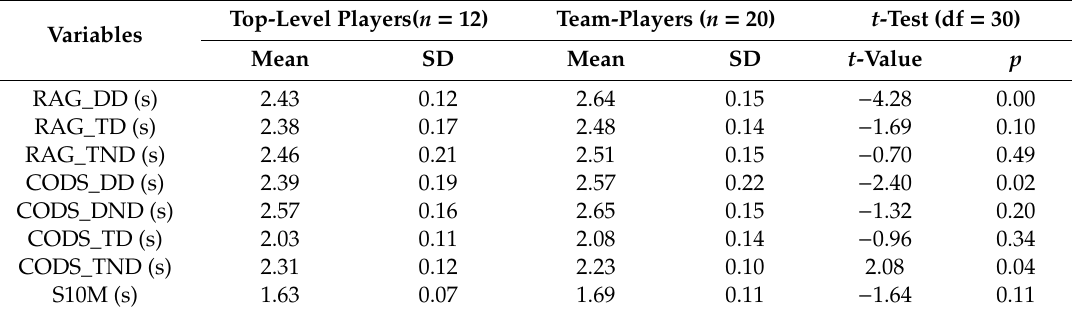
Table 4. Comparison between performance levels in the tested